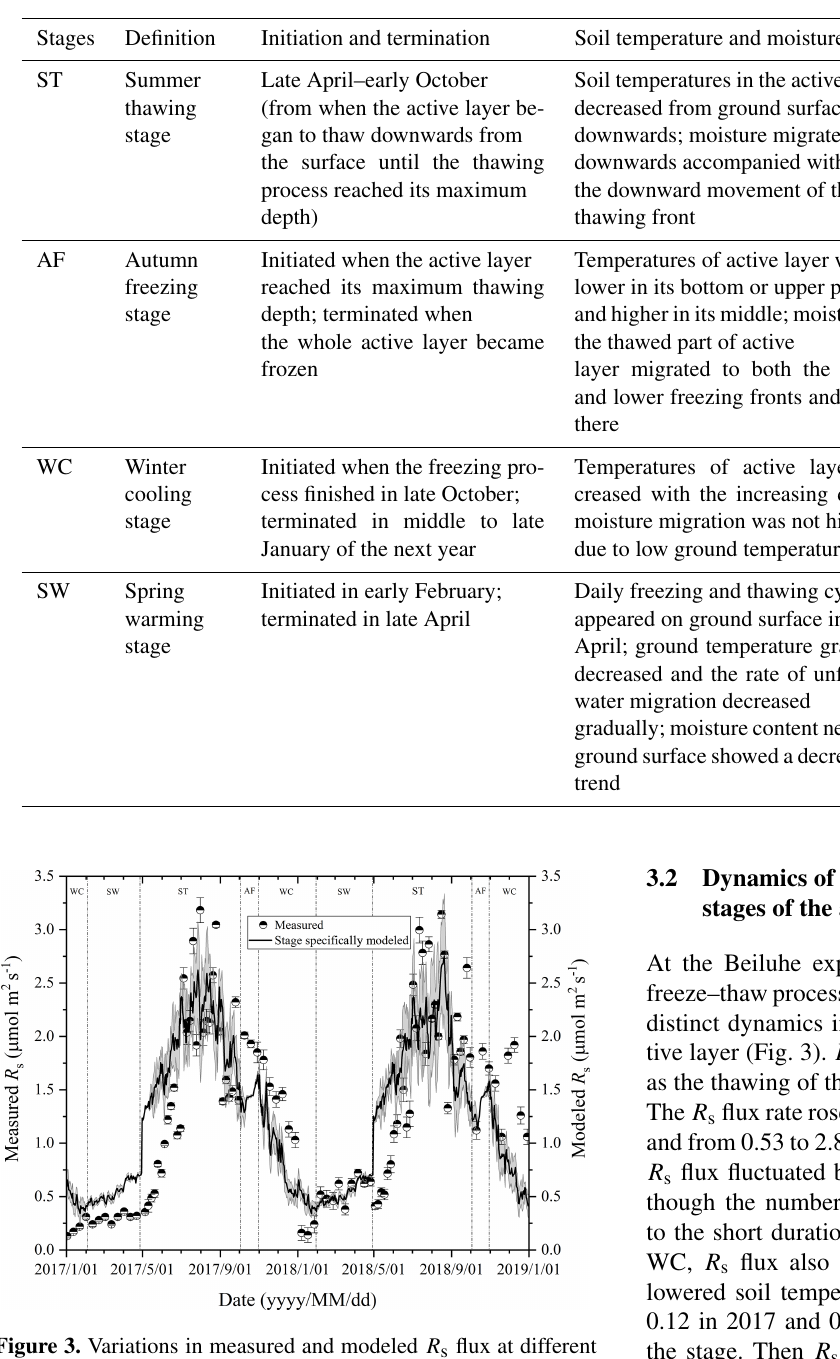
Figure 3. Variations in measured and modeled R s flux at different freeze–thaw stages in 2017 and 2018. Error bars show standard er- ror in measured R s ( n =